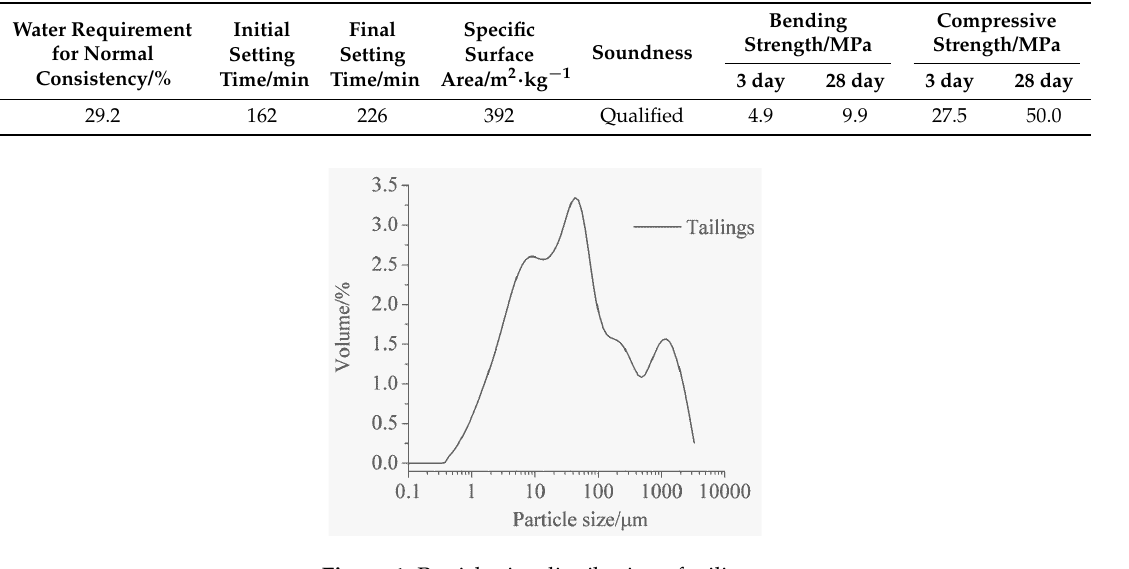
Figure 1. Particle size distribution of tailings.